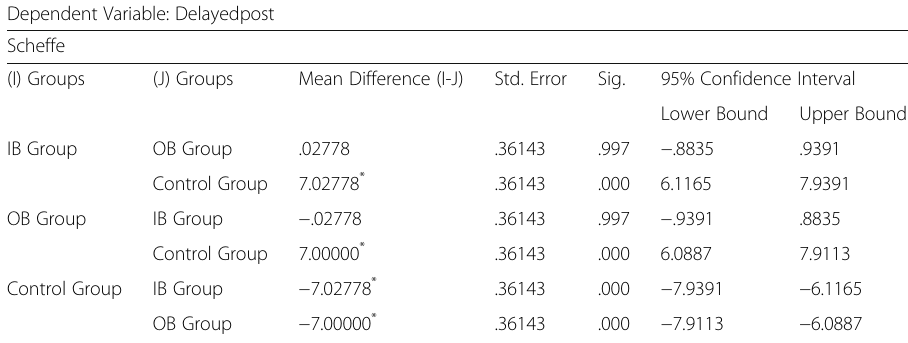
Table 9 Post-hoc Test, Multiple Comparisons (Delayed Post-tests) Dependent Variable: Delayedpost